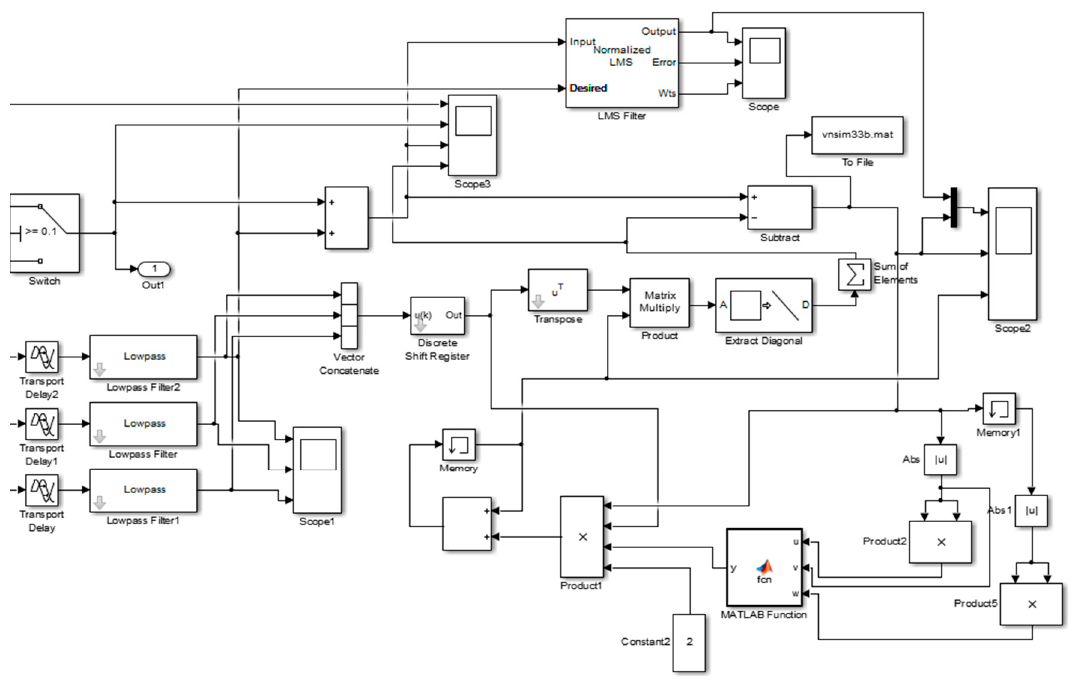
Figure A3. Simulink diagram for multi-channel noise cancellation using the regularized sigmoid variable step-size LMS (RSVSLMS).